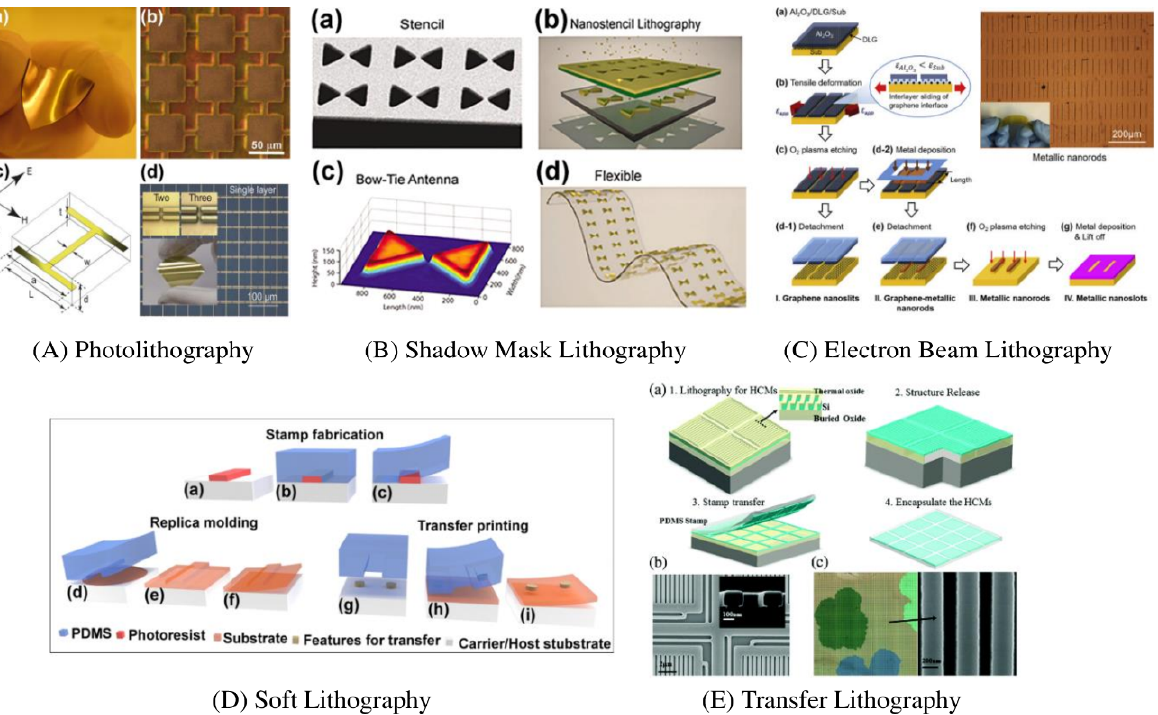
Figure 6. ( A ). Photolithography: Microfabricated terahertz metamaterials on flexible substrates, ( B ) Shadow Mask Lithography (SML): SML manufacturing sequence, ( A , B ) Reprinted with the permission of Copyright © 2018, Springer International Publishing AG). ( C ) Electron Beam Lithography (EBL): ( a – g ) Steps for the transferred double-layer graphene on a flexible substrate. (Reprinted with permission from Elsevier and Copyright Clearance Center), ( D ) Soft Lithography, ( a – c ) Fabrication of elastomeric stamps, ( d – f ) Replica molding ( g – i ) transfer printing, ( E ) Transfer Lithography: Flexible photonic metastructures ( a ) schematic for a high-contrast metastructure (HCM) preparation. ( b ) SEM images after etching. ( c ) Microscopic ( left ) and SEM ( right ) for the transferred HCMs on PDMS. (Reprinted with permission from Royal Society of Chemistry).